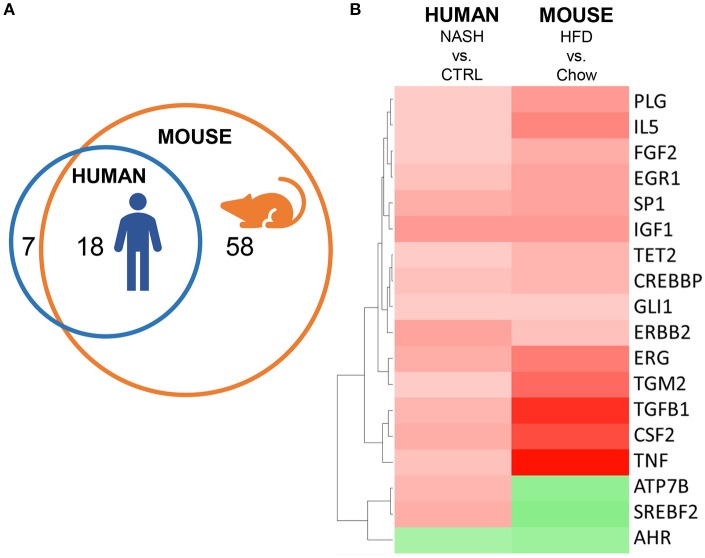
Representation of human inflammation-related upstream regulators in HFD-fed Ldlr−/−.Leiden mice. (A) Venn diagram to visualize the overlap in upstream regulators between human NASH biopsies (red circle) and Ldlr−/−.Leiden mice (blue circle). (B) Heatmap visualization of direction of regulation (Z-score). Red color indicates activated upstream regulator and green color indicates inhibited upstream regulator.